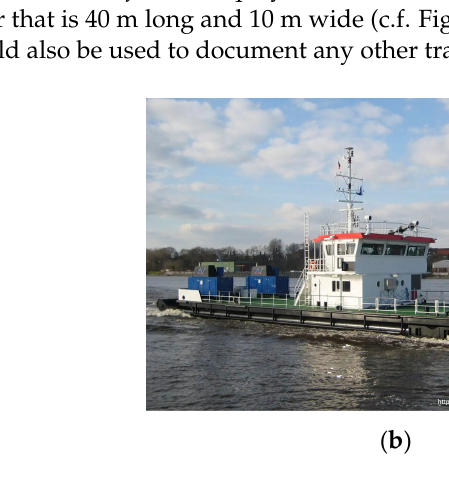
Figure 6 . ( a ) LiDAR sensor at the quay wall in Cuxhaven, Germany, to measure the distance be- tween the quay wall and vessels (part of the SmartKai infrastructure) ( b ) Dredger vessel Steubenhoeft with which the mooring maneuver that has to be documented was performed .